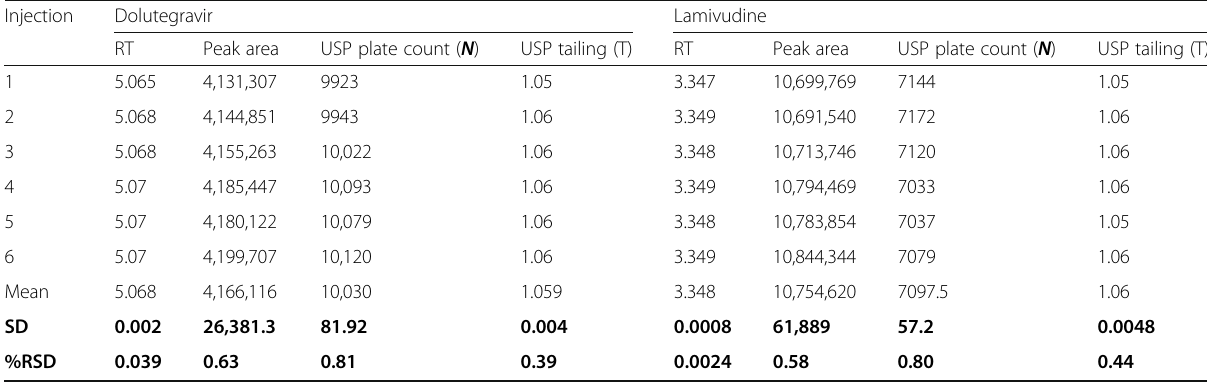
Table 2 Results of system suitability parameters of 100% level standard solution